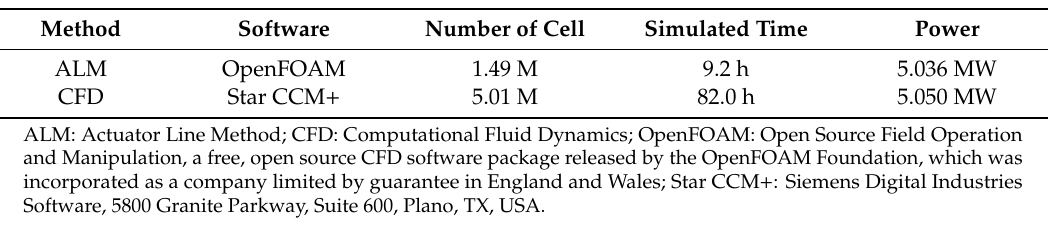
Table 4. Comparison of the computational cost between actuator line method (ALM) and computational fluid dynamics (CFD)